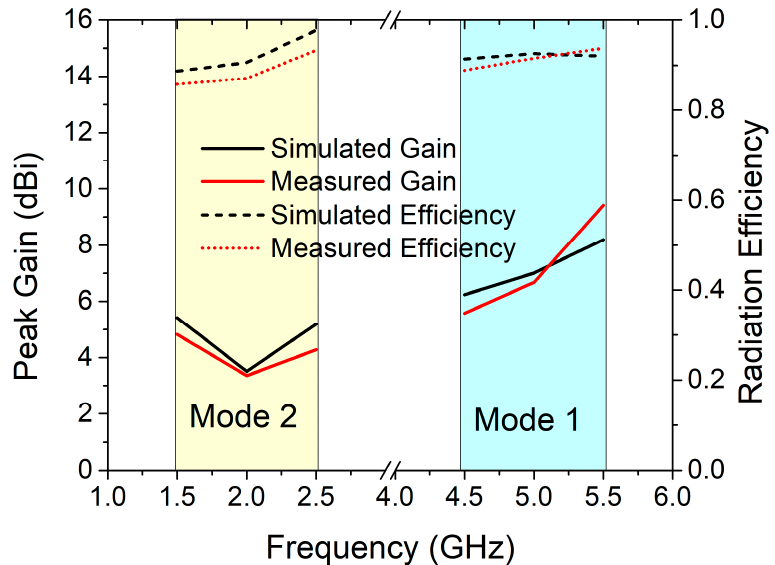
Figure 27. Peak gain and radiation efficiency in both modes.